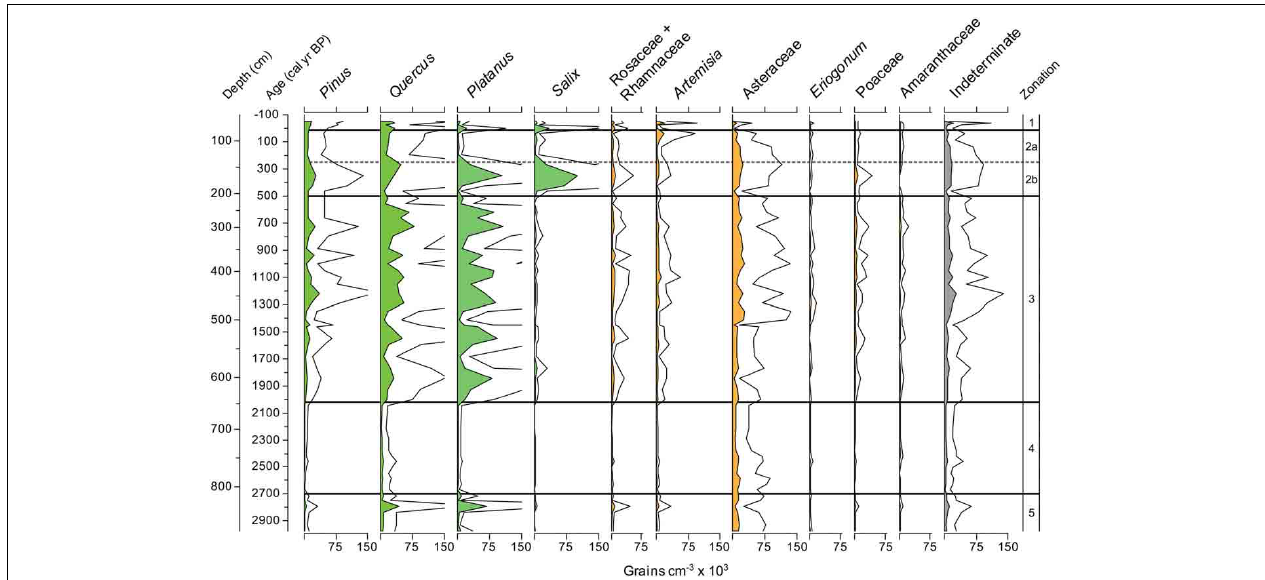
FIGURE 6 | Zaca Lake pollen concentration for the ten most common taxa plotted with indeterminate grains. Lines above the pollen percentages represent 3X exaggeration.